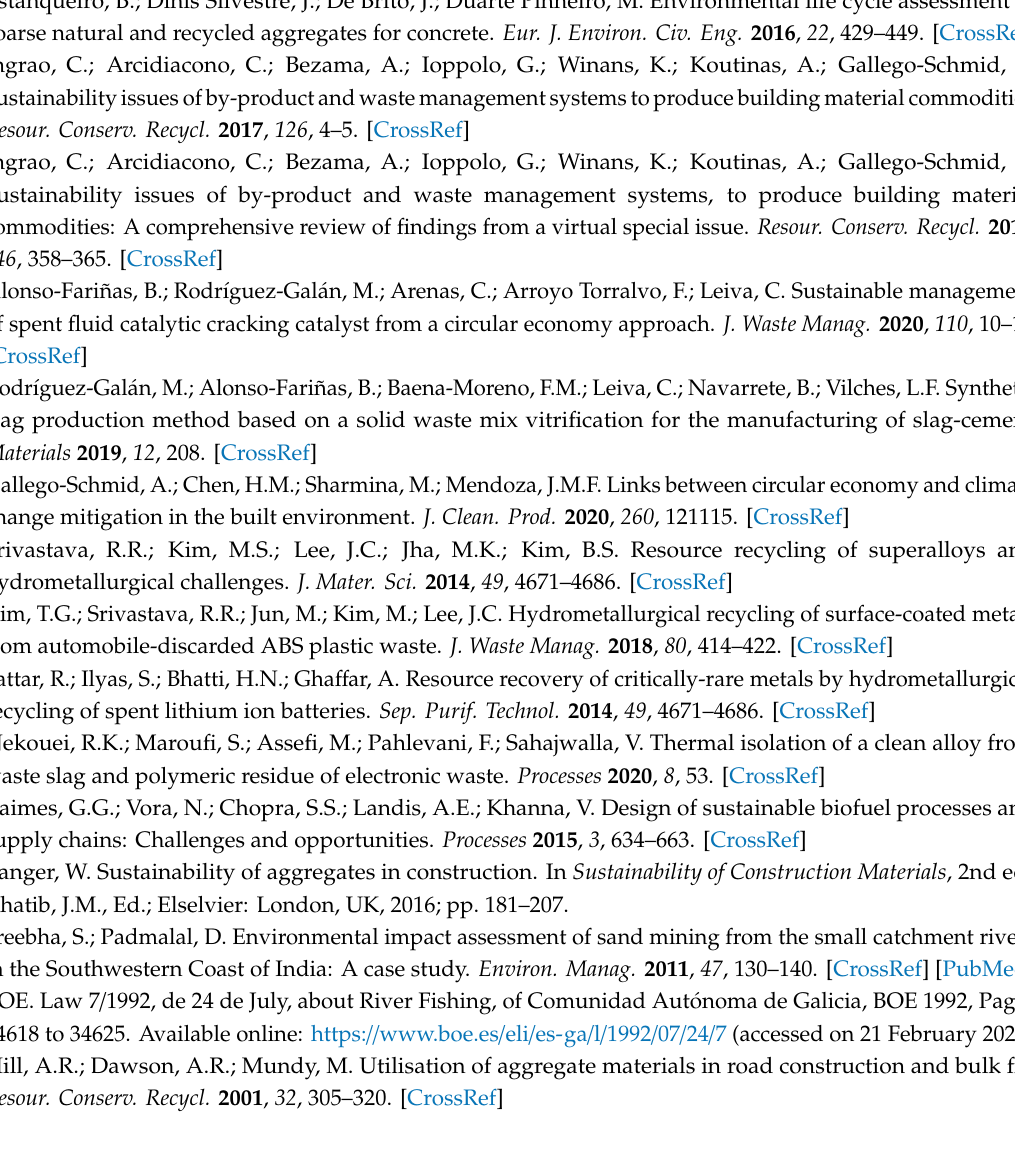
Figure S1: Acoustic noise barrier dimensions, Table S1: Inventory data for the seashell waste pre-treatment per 1 m 2 of noise barrier when di ff erent calcination temperatures are applied (PCSW, 550 ◦ C; PCSW-250, 250 ◦ C; PCSW-135, 135 ◦